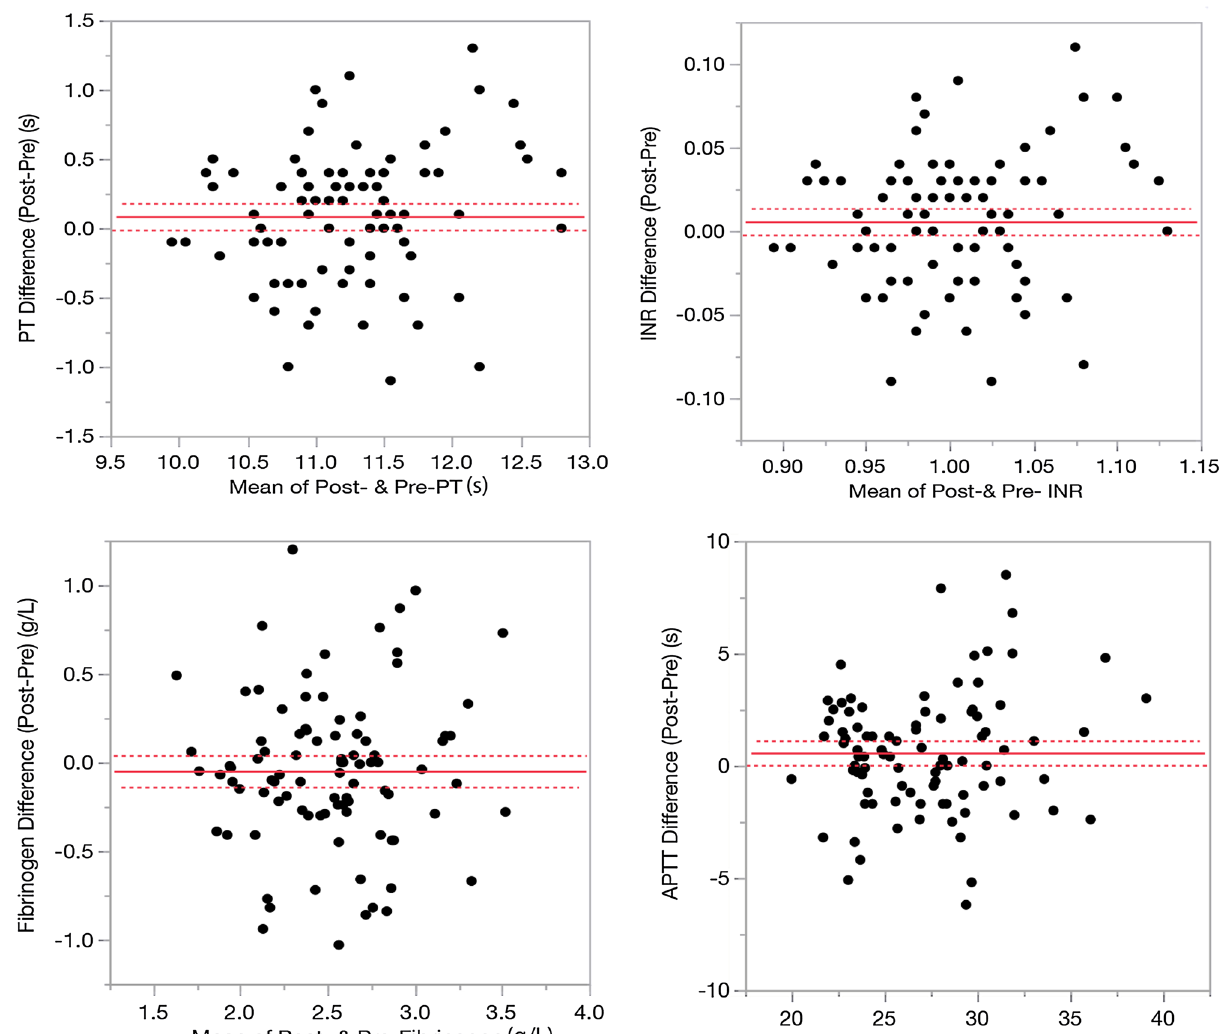
Figure 1. The differences plots of prothrombin time (PT, upper left), international normalized ratio (INR, upper right), fibrinogen (lower left), and activated partial thromboplastin time (APTT, lower right). The solid horizontal line in each frame represents the mean difference and the two dotted lines, encompassing the mean difference line, represent the 95% confidence